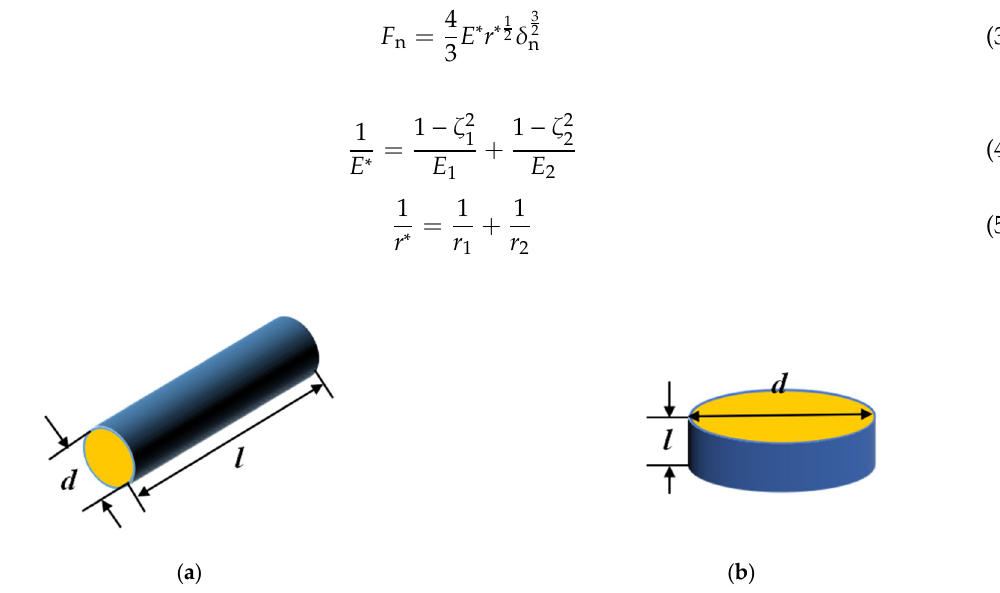
Figure 1. Geometries of ( a ) a rod and ( b ) a disk modeled in the present DEM simulations.